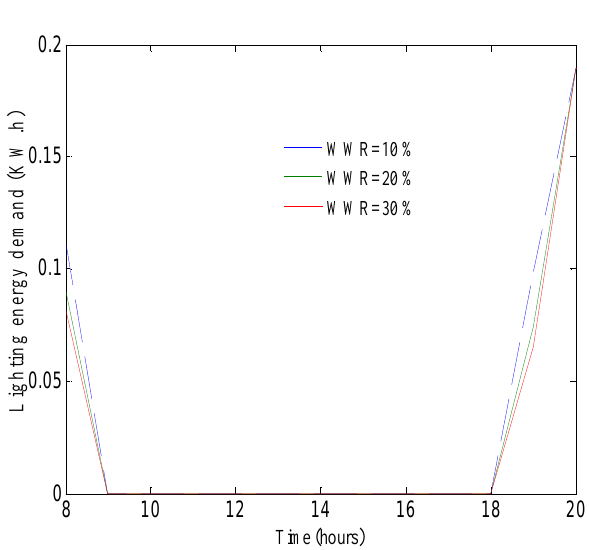
Figure 3. Lighting energy demand during a